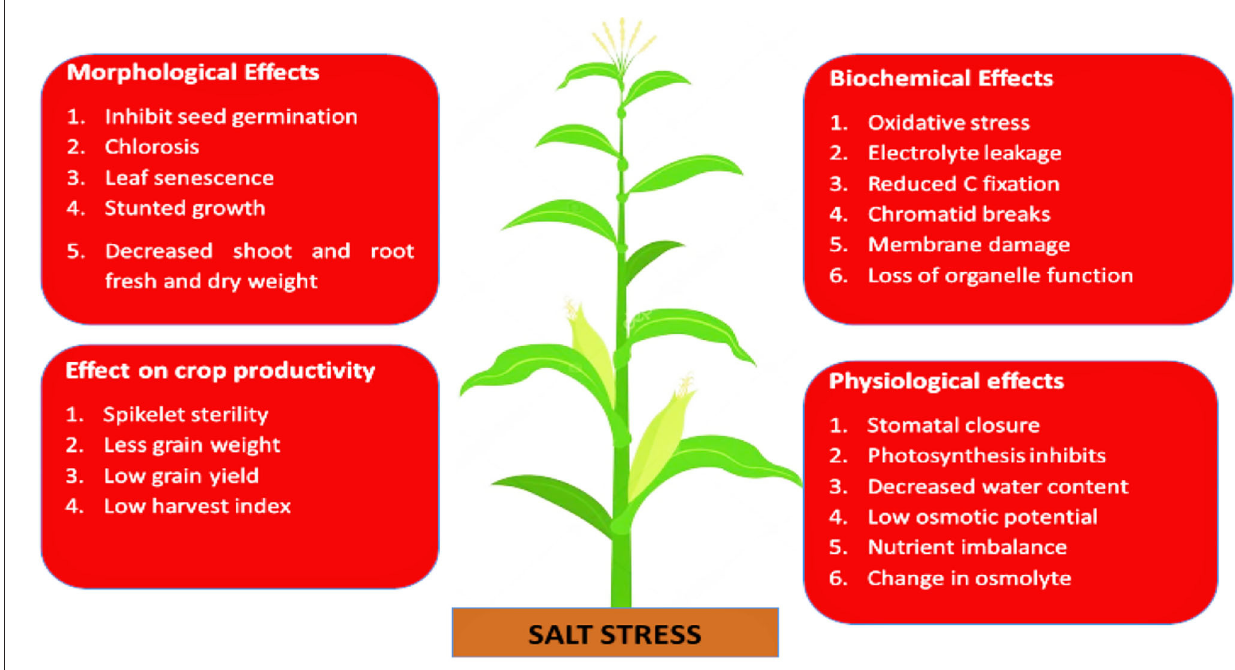
FIGURE 2 | Effects of salt stress on crop morphology and biochemical, physiological, and yield productivity.